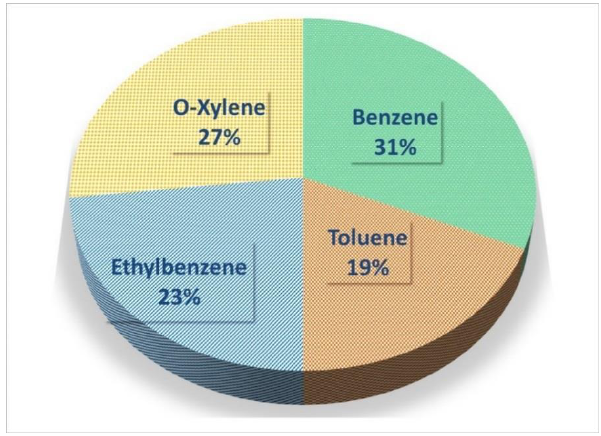
Figure 3. The percentage of BTEX in the ambient air of Tehran.